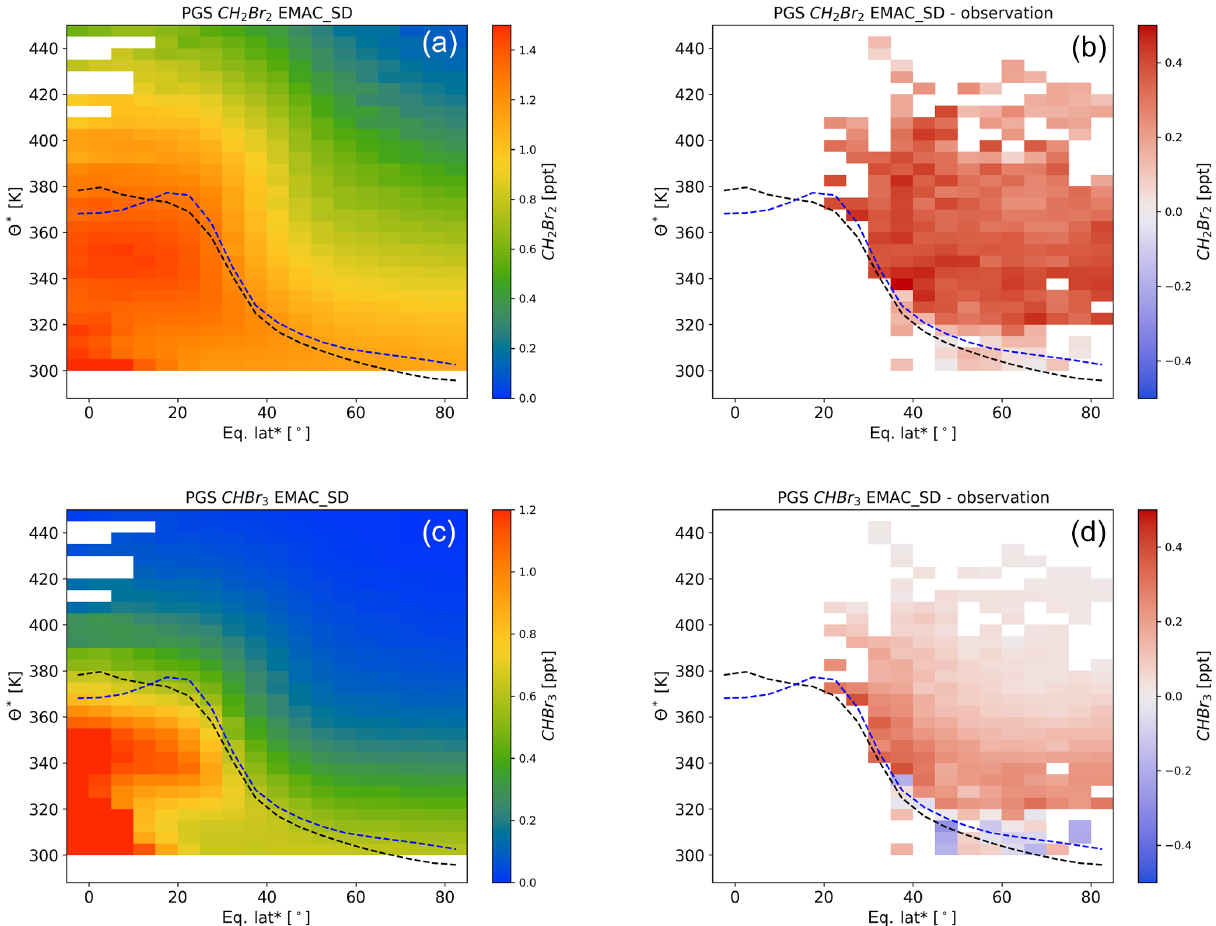
Figure 12. As Figs. 9–11 but for the EMAC model using the Warwick et al. (2006) emission